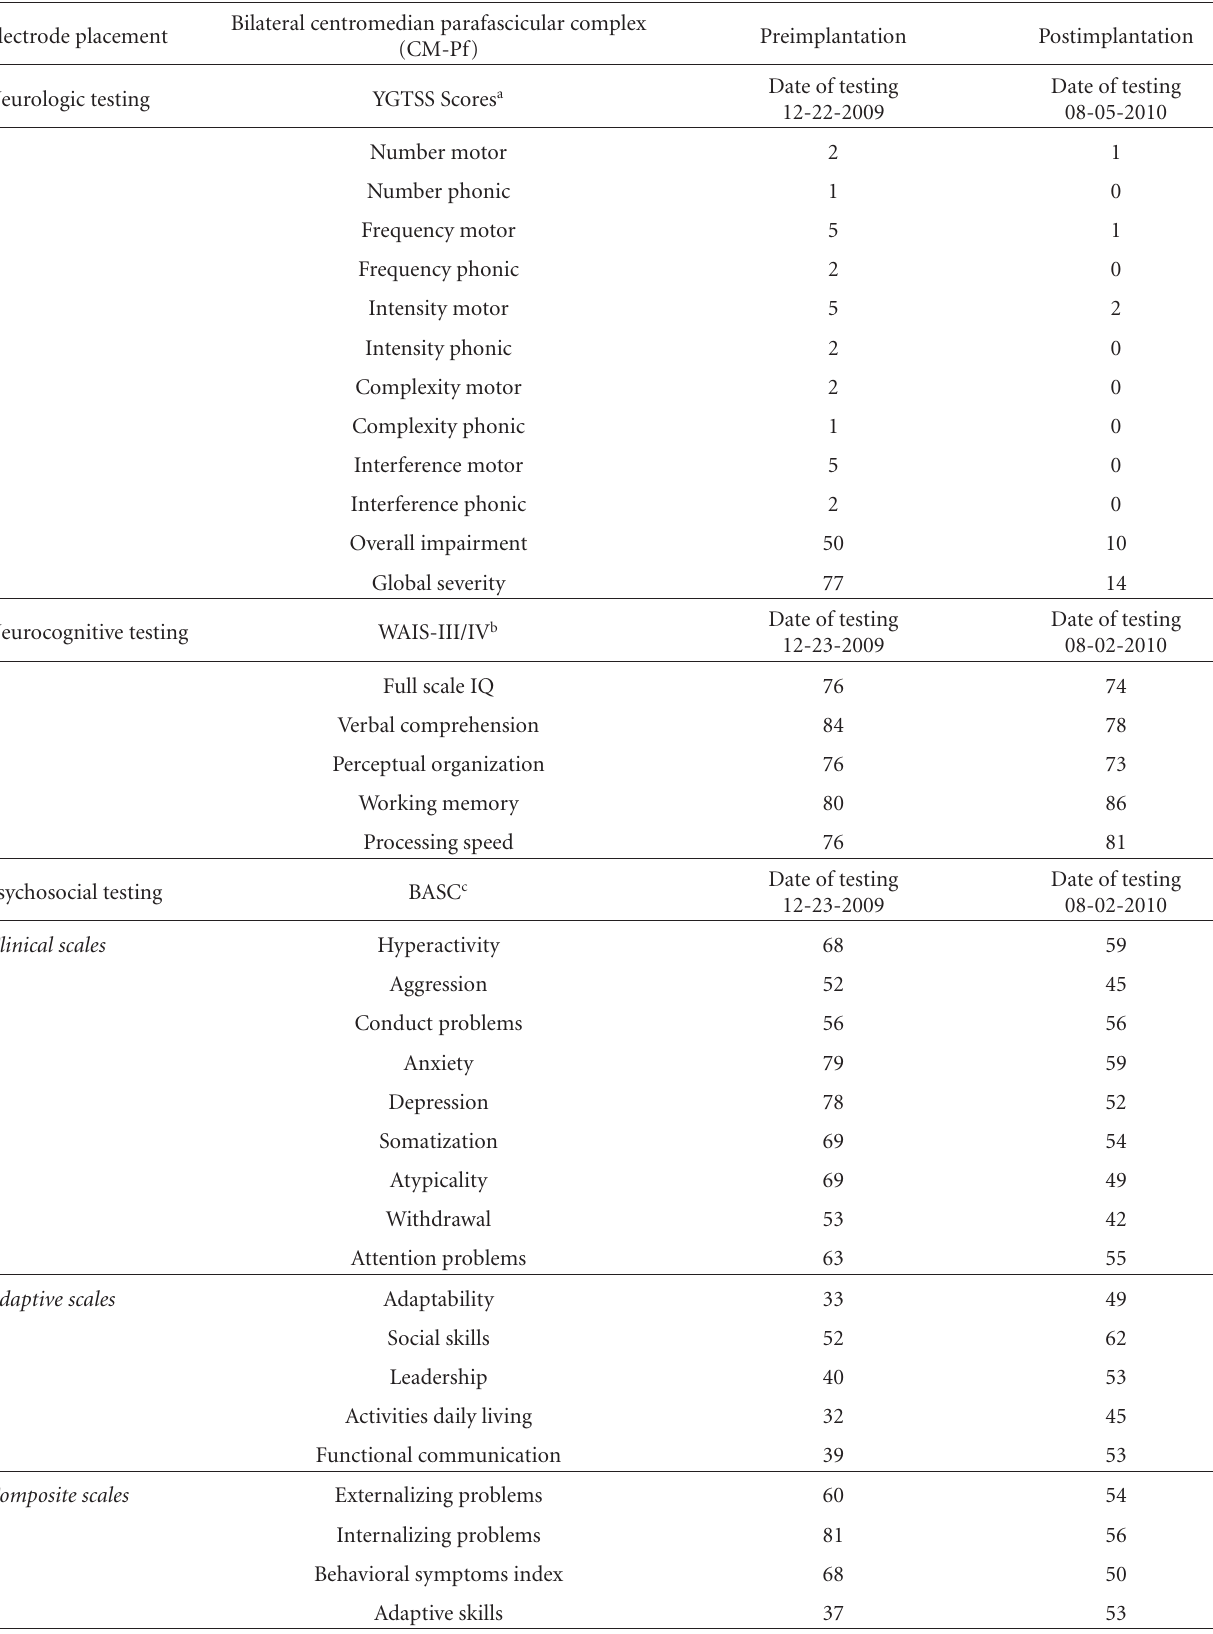
Table 1: Results of neurologic examination, neurocognitive testing, and psychotropic medication load pre- and postelectrode implantation. Electrode